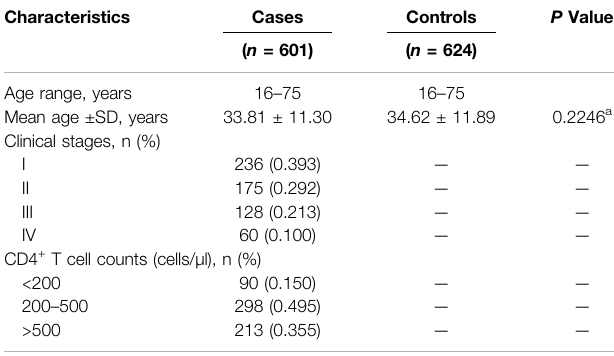
TABLE 1 | Characteristics of HIV-infected individuals and healthy